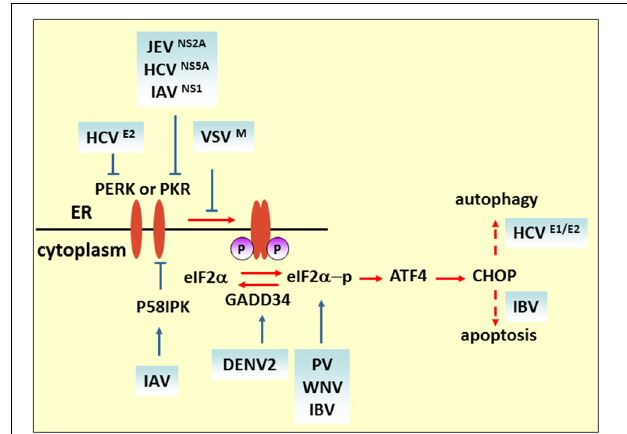
FIGURE 2 | eIF2 pathway under viral infection. The M protein of VSV, the E2 and NS5A proteins of HCV, and NS2A of JEV counteract the phosphorylation of eIF2 α for viral replication. Blue solid arrows indicate the direct target of the virus or viral proteins. IAV also targets eIF2 α by inducing P58IPK, a cellular inhibitor of PERK and PKR. IBV upregulates eIF2 α –ATF4–CHOP-mediated apoptosis to benefit viral